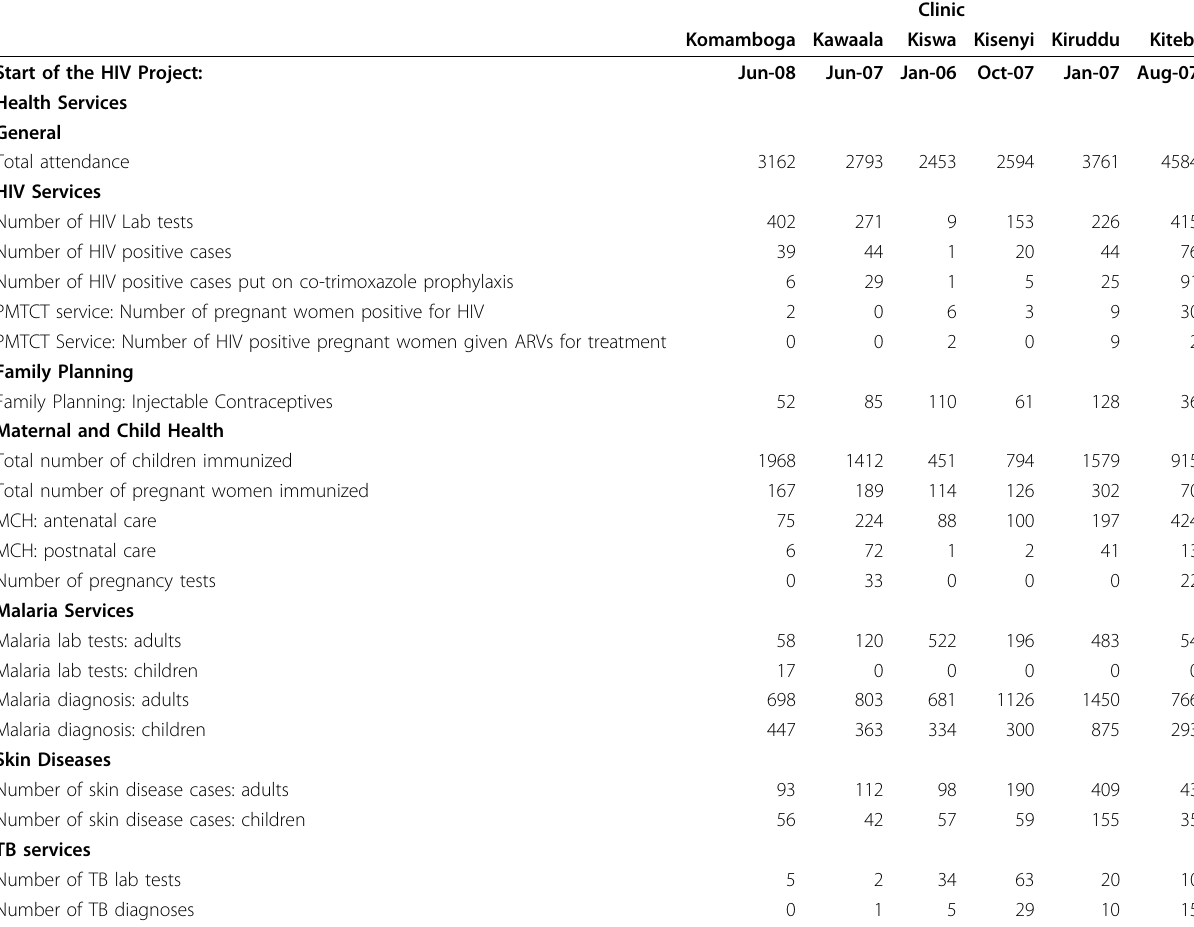
Table 1 Baseline number of health services provided in the month before the project